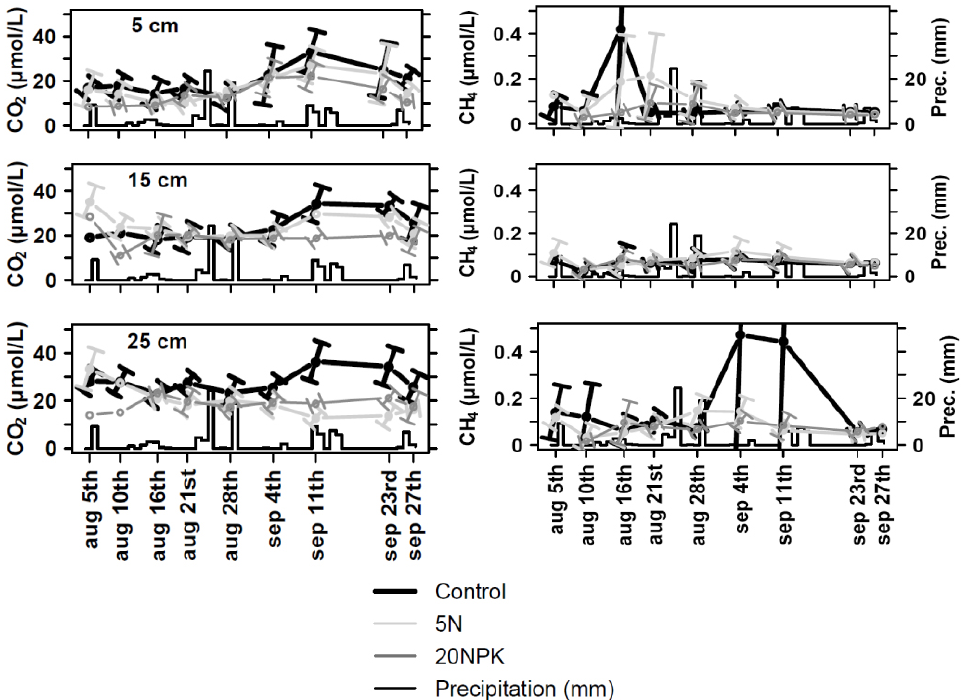
Fig. 4. Means of CO 2 and CH 4 -concentrations and associated standard deviations for the whole measurement period in the unsaturated zone. Additionally, precipitation is shown. Standard deviations are sloped for better illustration.